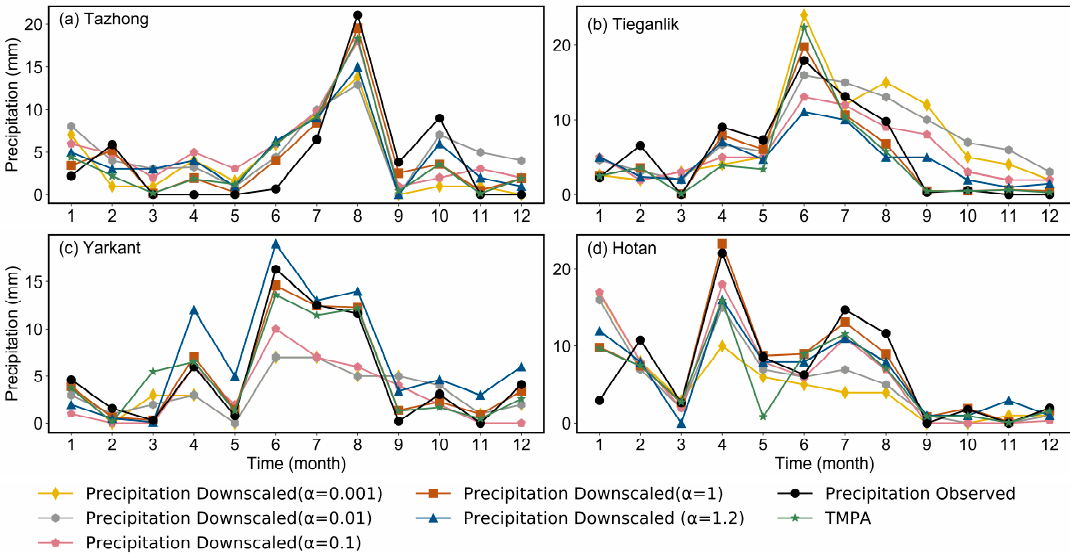
Figure 4. The comparison of observation data and downscaling results of 2018. ( a – d ) are the subgraphs of Tazhong, Tieganlik, Yarkant, Hotan. Table 1. Validation of the downscaling model based on the observation data in 2018.